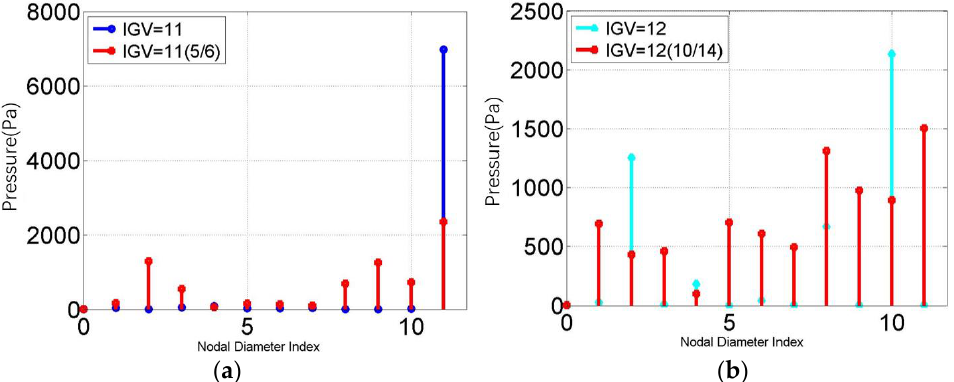
Figure 13. Circumferential wave spectrum of asymmetric mistuned stators: ( a ) IGV = 11 ( 10/12 ) , ( b ) IGV = 12 ( 10/14 ) .